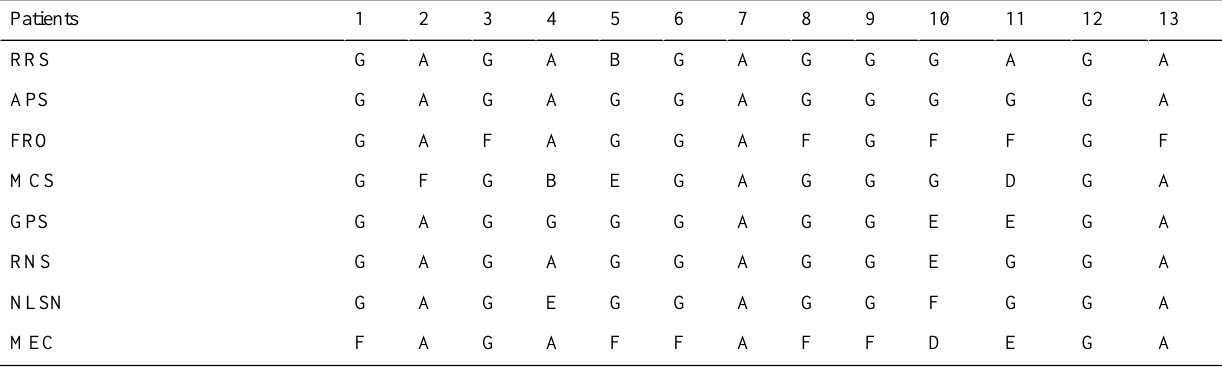
Table 8. Summary of responses of patients to the SADL a .